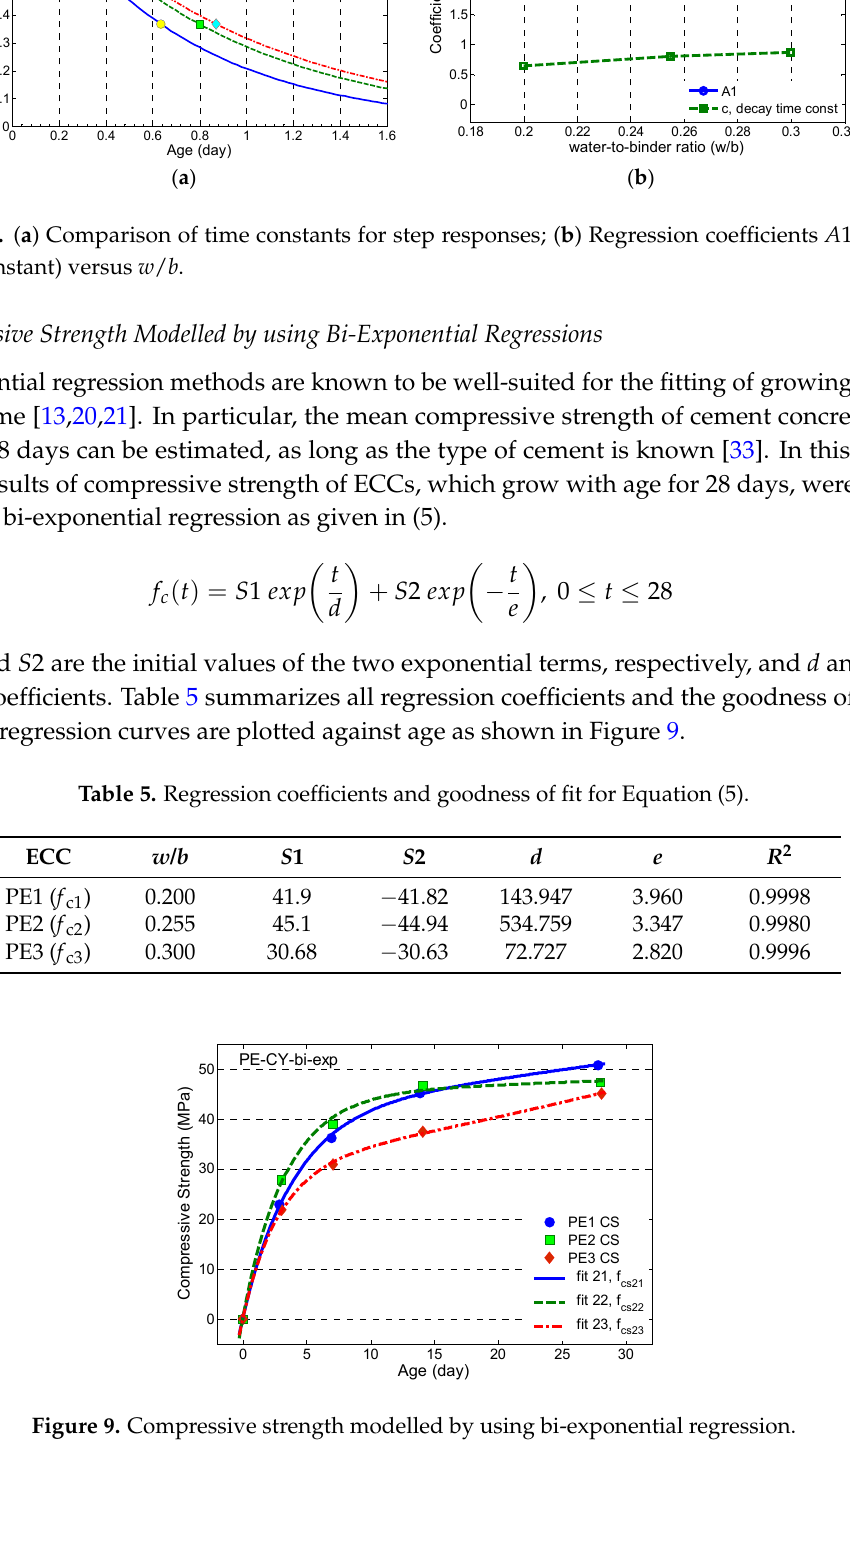
Figure 9. Compressive strength modelled by using bi ‐ exponential regression.